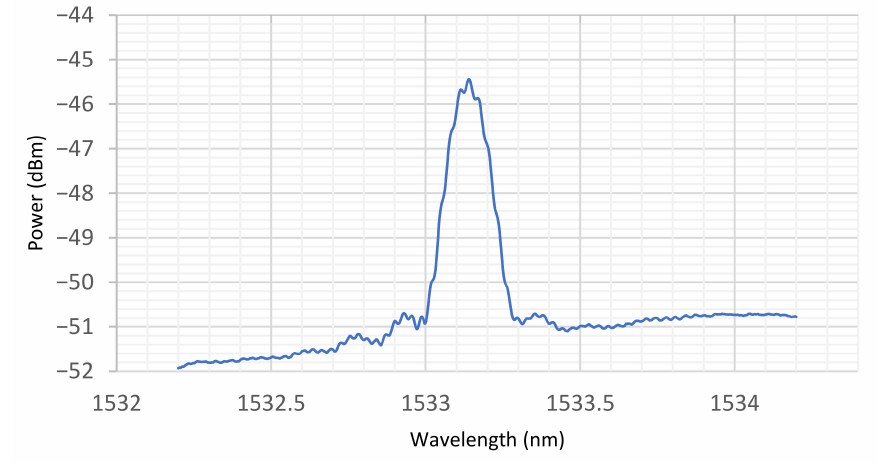
Figure 2. POFBG reflection spectrum.